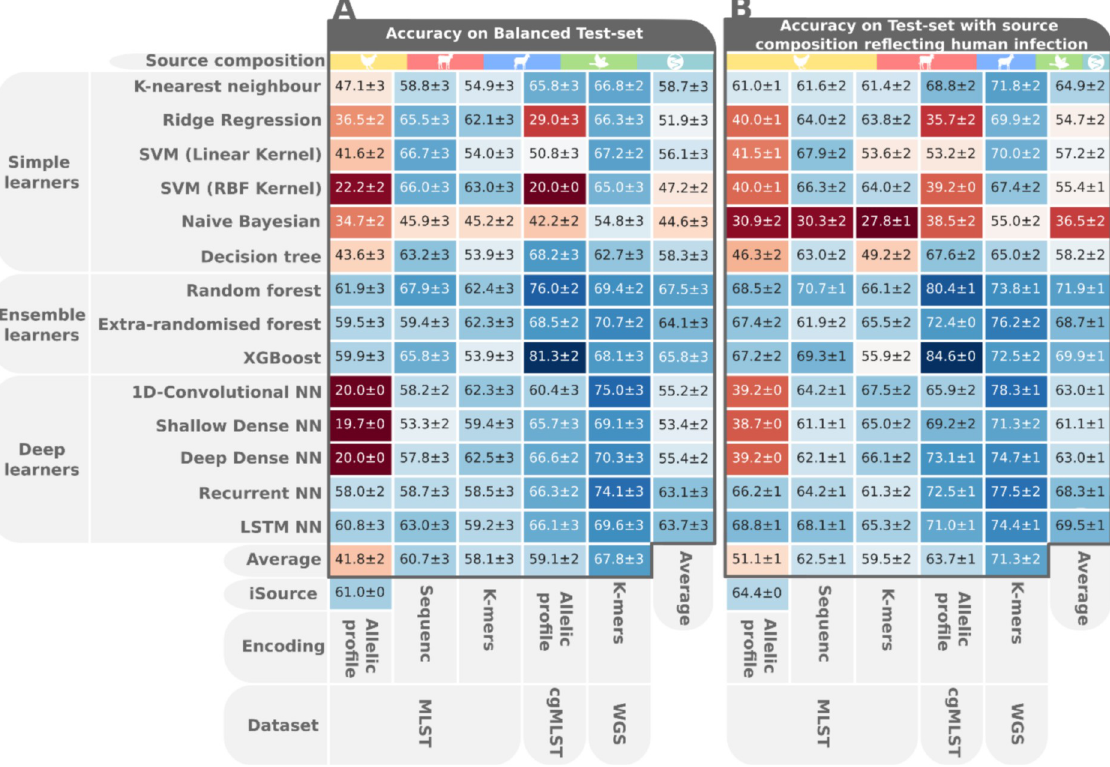
Fig 1. A heatmap showing classifier performance on the class balanced (A) and imbalanced (B) test set. The individual cells are coloured according to the average accuracy on 200 rounds of resampling with replacement with one standard error noted next to the average accuracy. The averages of accuracy per classifiers are shown in the rightmost column, whereas the bottom column shows the averages per data type.